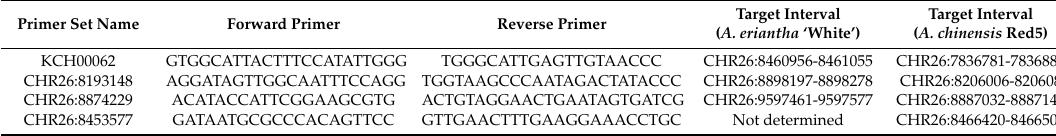
Table 4. Primer sets used for high-resolution melting (HRM) in this study and their target intervals on genome